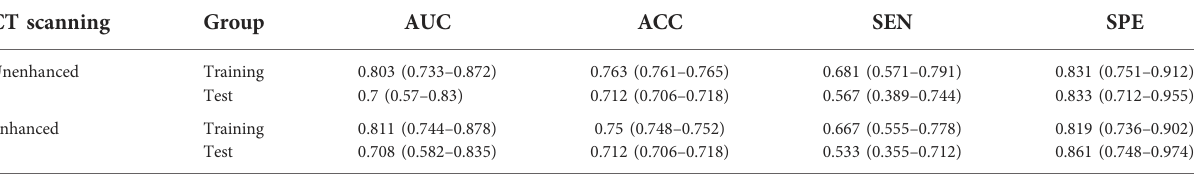
TABLE 5 Prediction ef fi ciencies of the unenhanced and enhanced models. CT scanning